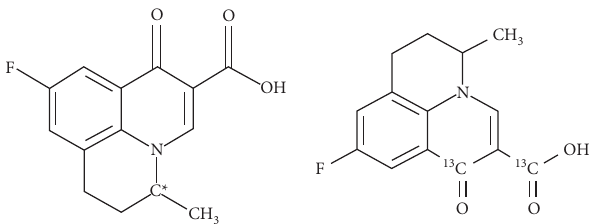
Figure 1: Chemical structure of FLU ( C ∗ � chiralcenter ) and 13 C marked